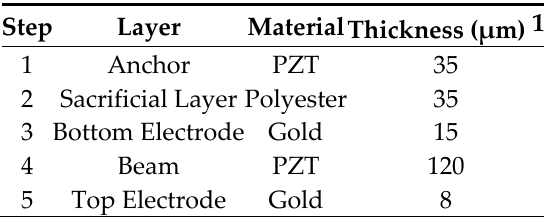
1 Thickness indicated after drying and before firing of the